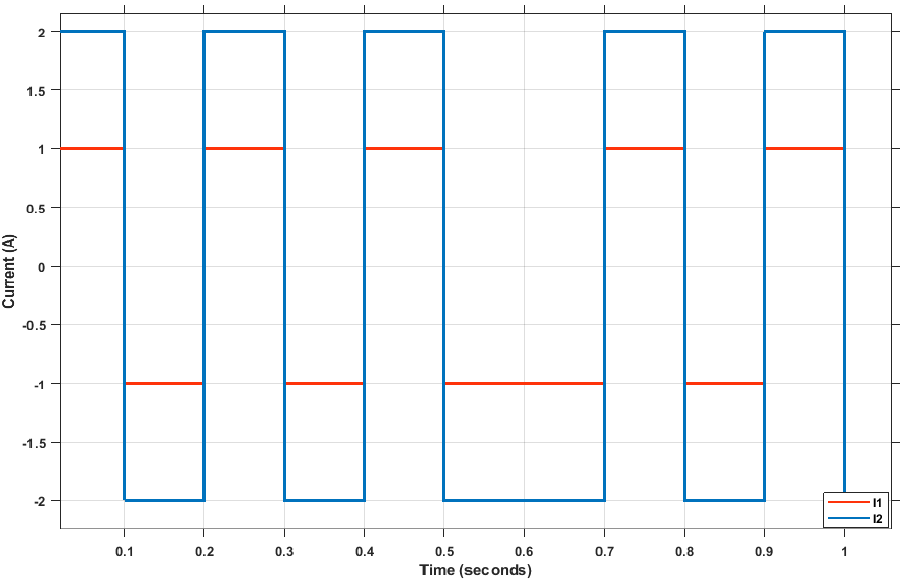
Figure 11. Change of the current and power flow direction as a result of a repeated and very aggressive step change in power flow direction.